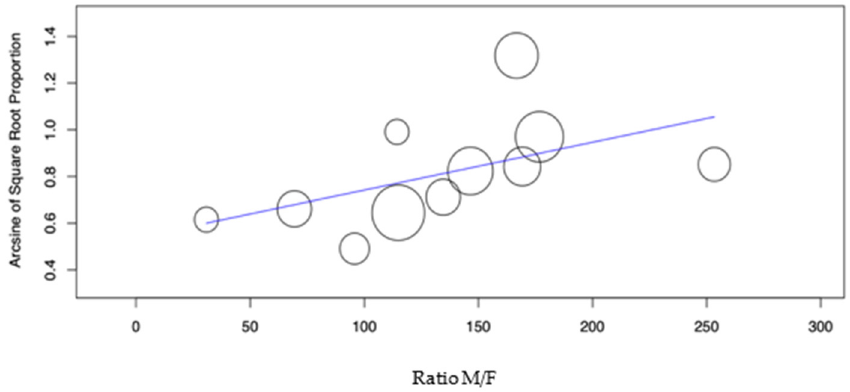
Figure 6. Meta-regression of the Ratio M/F variable versus caries incidence for the DS group.